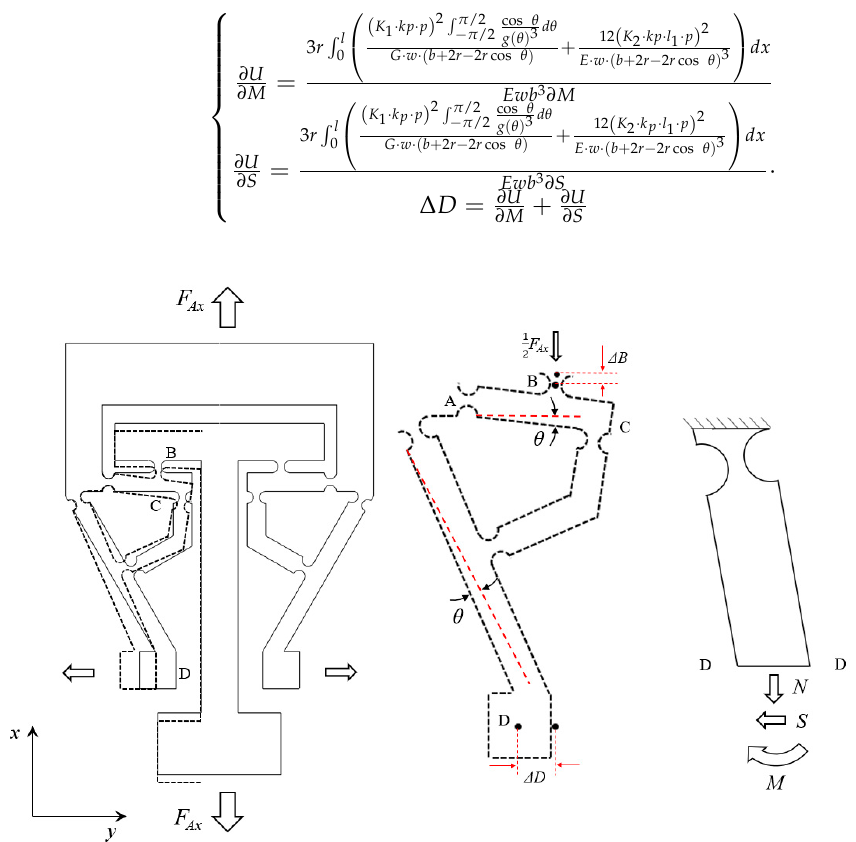
Figure 7. Mechanical diagram for one-half model.